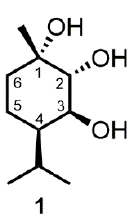
Figure 1. Structure of (-)-(1 S ,2 R ,3 S ,4 R )-trihydroxy- p -menthane ( 1 ).